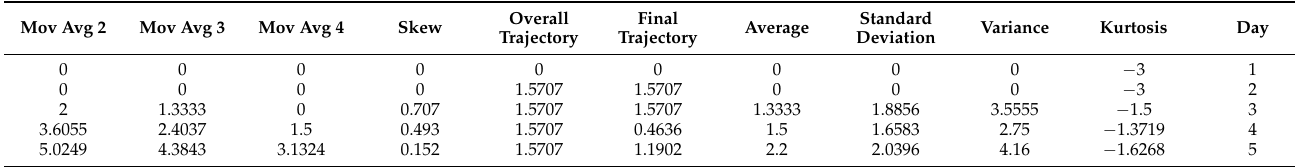
Table 4. A Sample Feature Table.